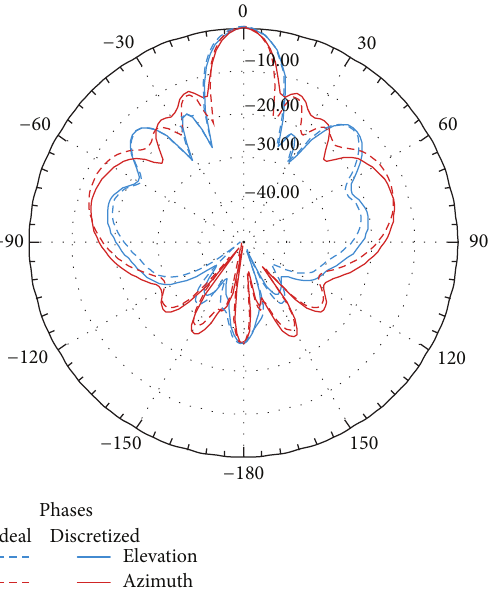
Figure 10: Pattern generated by a virtual array of 5 contiguous subarrays on the full cylindrical array (broadside direction). Dashed lines are obtained with ideal phase shifts and solid lines with discretized phase shifts.